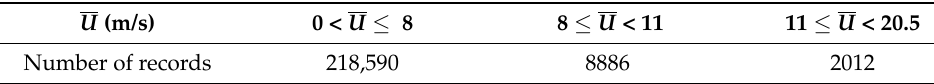
Table 2. Classes of membership of the 10-min mean wind velocity U . U